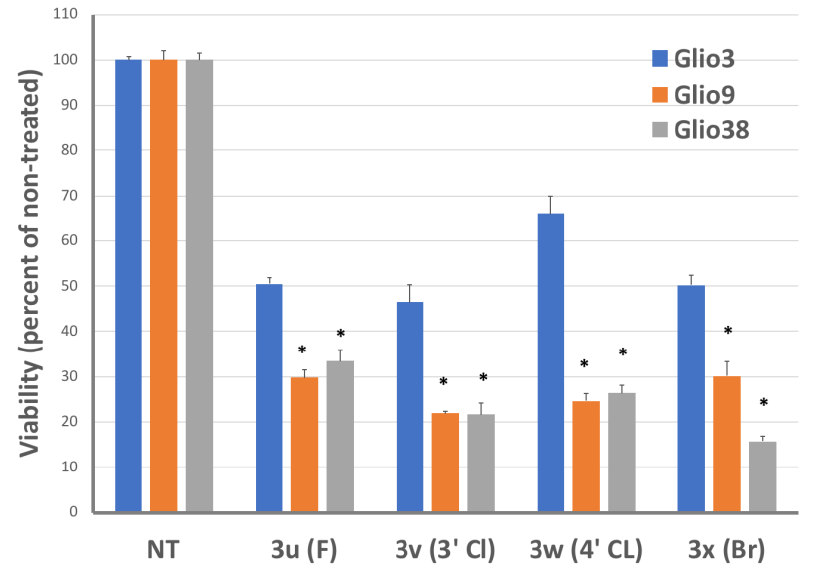
Figure 1. Effect of halogen substituted chalcones on GSC viability. GSCs (Glio3, Glio9, Glio38) were treated with 10 µM of chalcones; 3u , 3v , 3w and 3x and viability determined 72 h later. * p < 0.05 compared to non-treated controls.